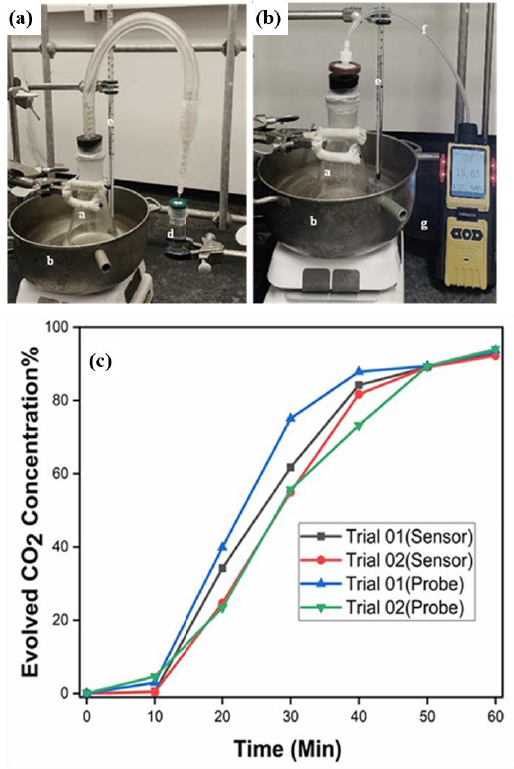
Figure 7. Fermentation setup to detect the evolution of CO 2 gas ( a ) with complex ( b ) using a CO 2 probe (a = fermentation flask; b = 37 °C water bath; c = connecting tube with a needle attached to the end; d = sensor solution to receive CO 2 gas from the fermentation setup; e = thermometer; f = con- necting tube with a dust filter; g = probe). ( c ) Data plot showing the determination of CO 2 gas con- centration with time using complex 1 and a CO 2 probe. (Also see Tables S8 and S9 and Figure S11).